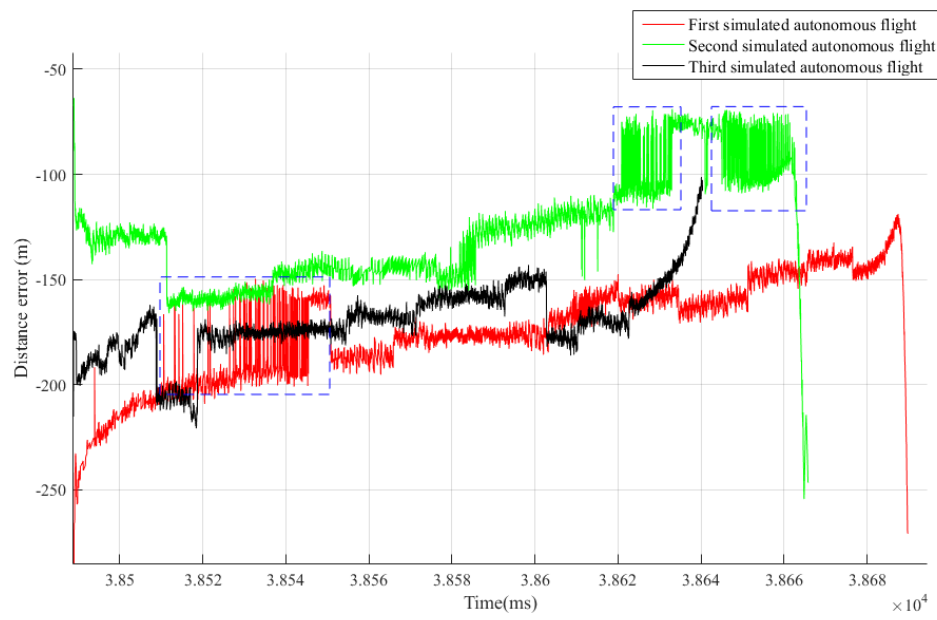
Figure 15. Spatial compound distance error of the target position measured by the airborne radar.